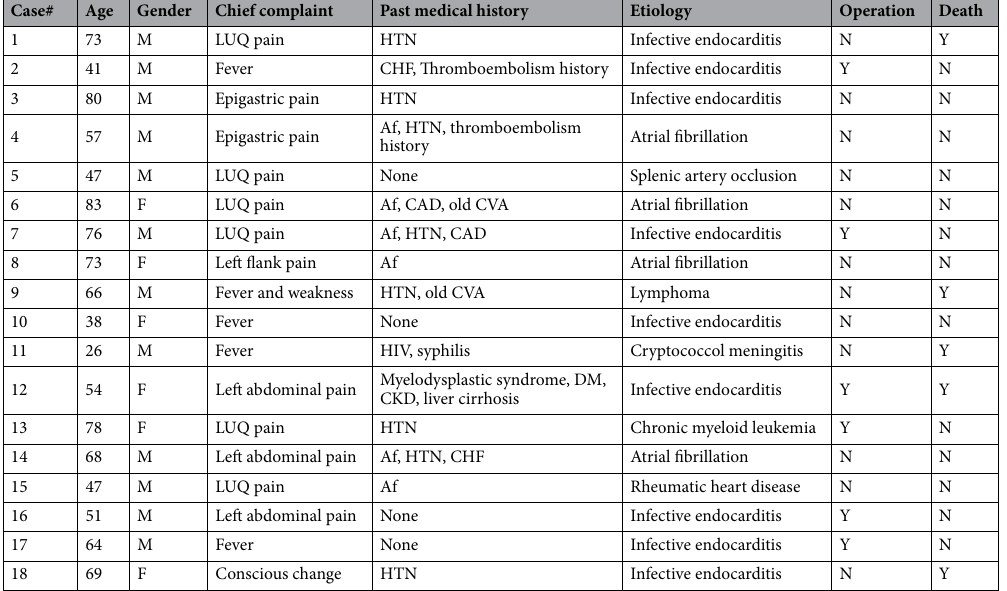
Table 5. Patient list of ICU